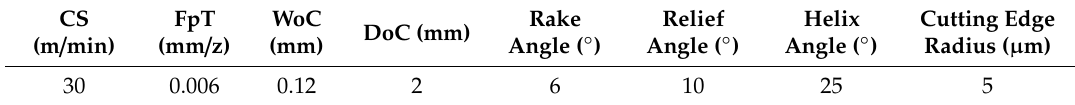
Figure 14. Response relationships between ultrasonic parameters and cutting force. ( a ) Cutting force Fx; ( b ) Cutting force Fy. Table 7. Cutting and tool geometry parameters.